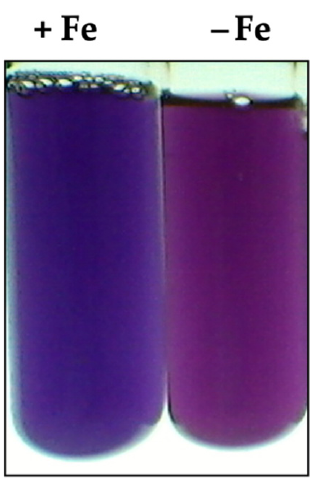
Figure 7. Production of siderophores by G. diazotrophicus PAL5 strains in response to iron availabil- ity.